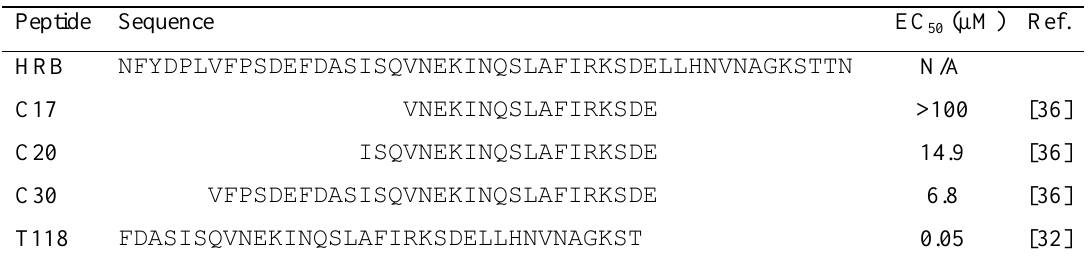
Table 1. Inhibitory activity of peptides derived from the RSV F protein heptad repeat B (HRB) region on RSV